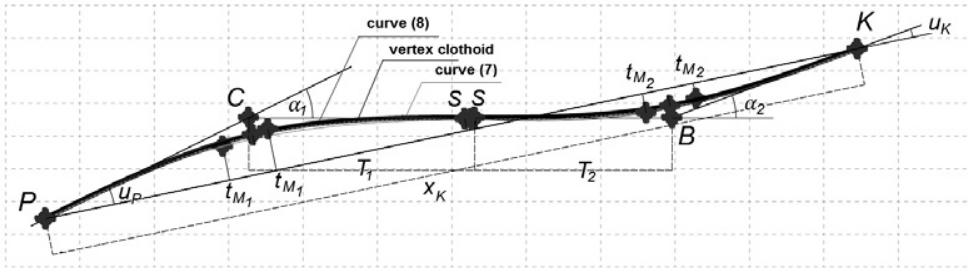
Figure 8. Reverse curves: symmetric vertex clothoids vs S -shaped transition curves (variant II)